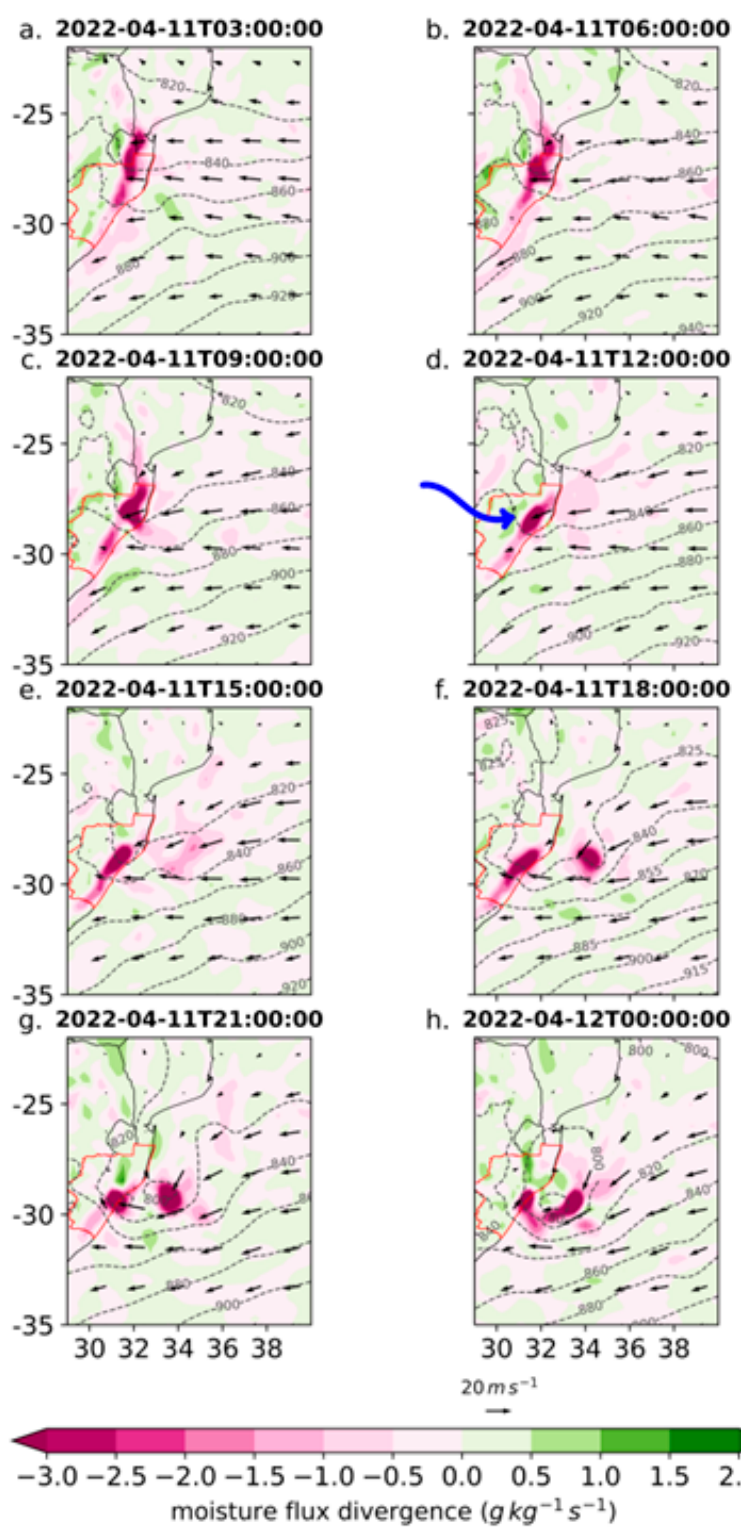
Figure 6. ERA5 moisture flux divergence (shaded; g kg − 1 s − 1 and the order of magnitude of the values are 1 × 10 − 3 ) and wind speed (vectors; m.s − 1 ) at the 925 hPa pressure level at 3 h intervals for ( a ) 0300 UTC, ( b ) 0600 UTC , ( c ) 0900 UTC, ( d ) 1200 UTC, ( e ) 1500 UTC, ( f ) 1800 UTC, ( g ) 2100 UTC on 11 April 2022 and ending at ( h ) 0000 UTC 12 April 2022. The position of the meso-trough is highlighted by the blue arrow in panel d.